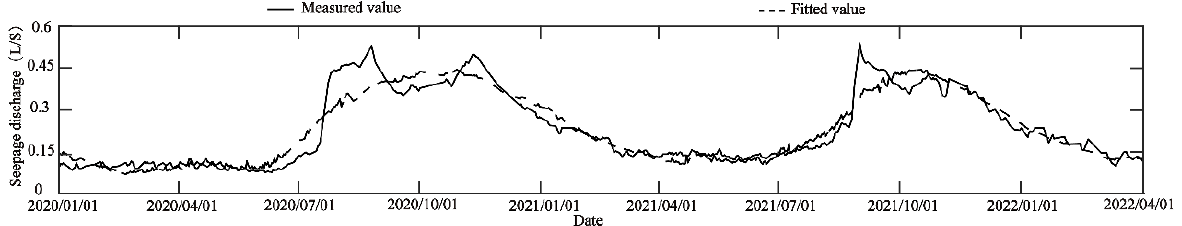
Figure 7. Fitting process line of seepage discharge at measuring point WE01ZXD.